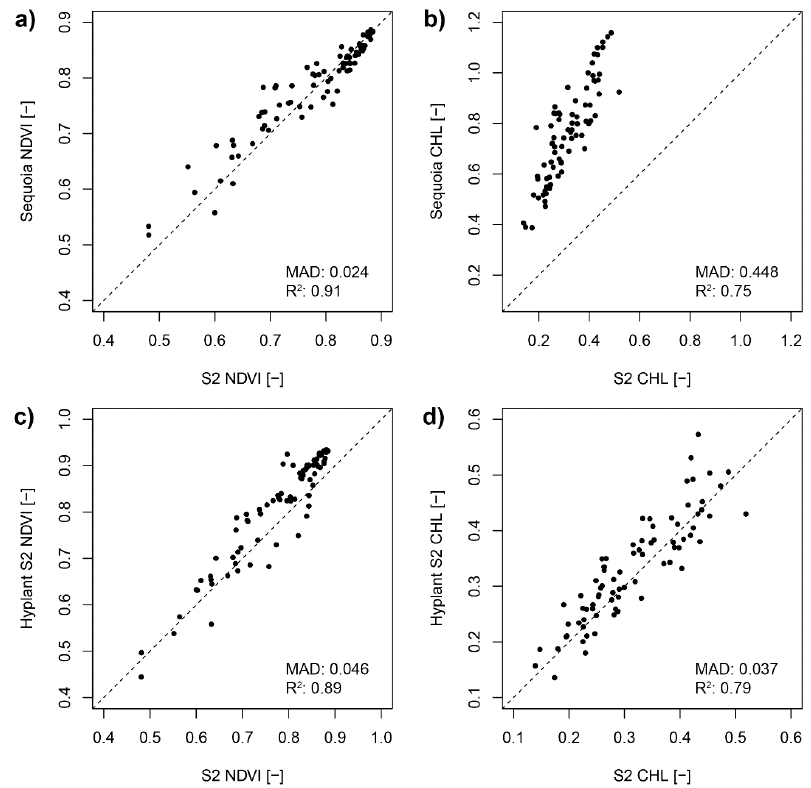
Figure 10. Top: Scatterplots of NDVI ( a ) and CHL values ( b ) derived from S2 and Sequoia imagery (resampled to 20 m spatial resolution). Bottom: Scatterplots of NDVI ( c ) and CHL values ( d ) derived from S2 and HyPlant imagery (resampled to 20 m spatial resolution).